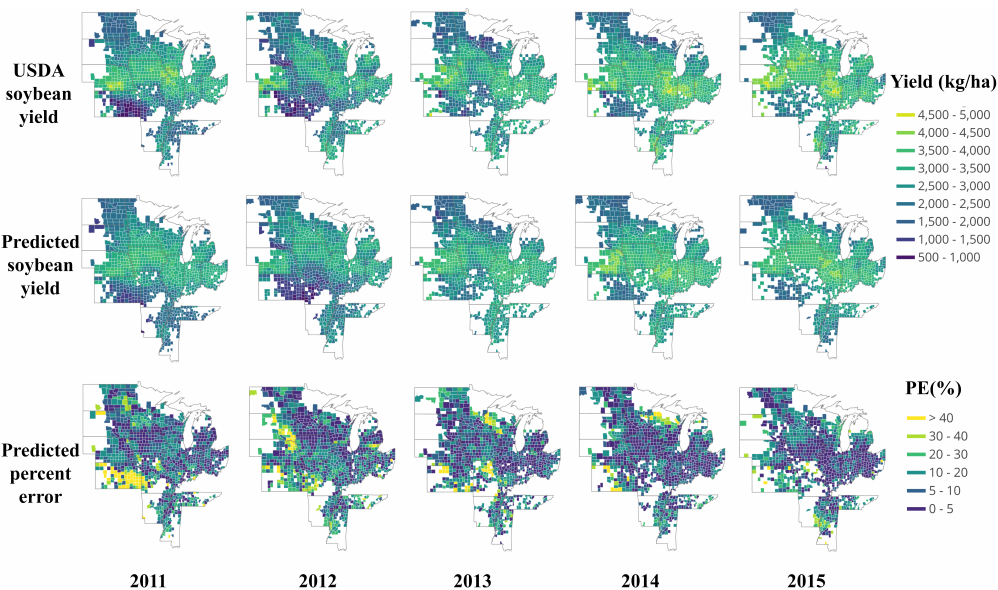
Figure 8. Map of USDA soybean yield, CNN-LSTM in-season predicted soybean yield and PE from 2011 to 2015.